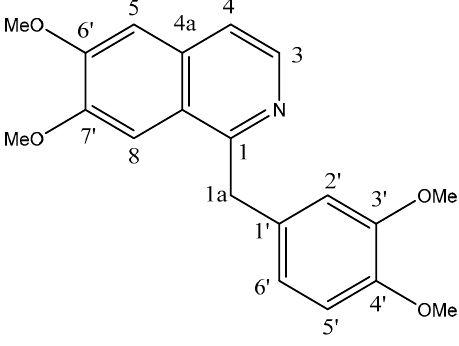
Figure 1. Chemical structure of papaverine drug.